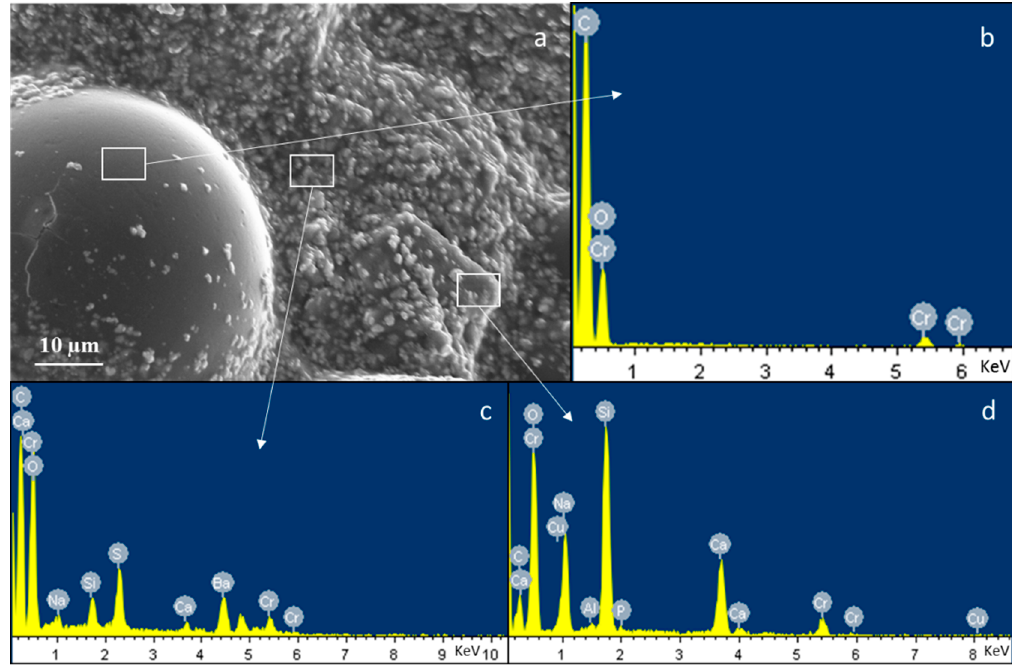
Figure 1. Field emission scanning electron microscopy (FESEM) and EDS analysis of high viscosity composite bone cement (CEMEX ® ISO-Cu); ( a ) morphology, ( b ) compositional analysis of PMMA sphere, ( c ) compositional analysis of BaSO 4 and ( d ) compositional analysis of glass particles embedded in the polymeric matrix.